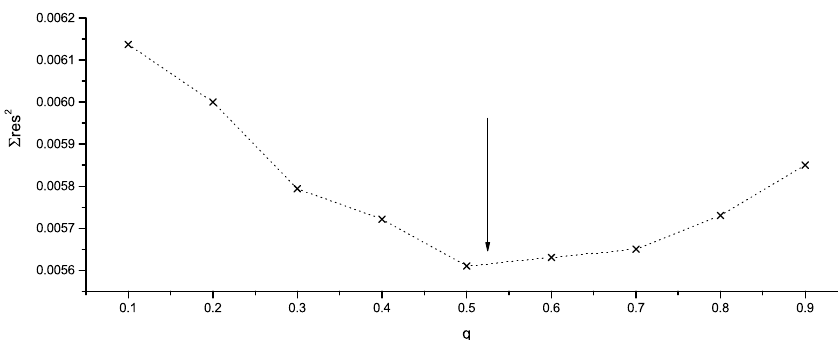
Figure 4. q -search plot for KIC 8504570. The arrow denotes the final adopted q value after the iterations.